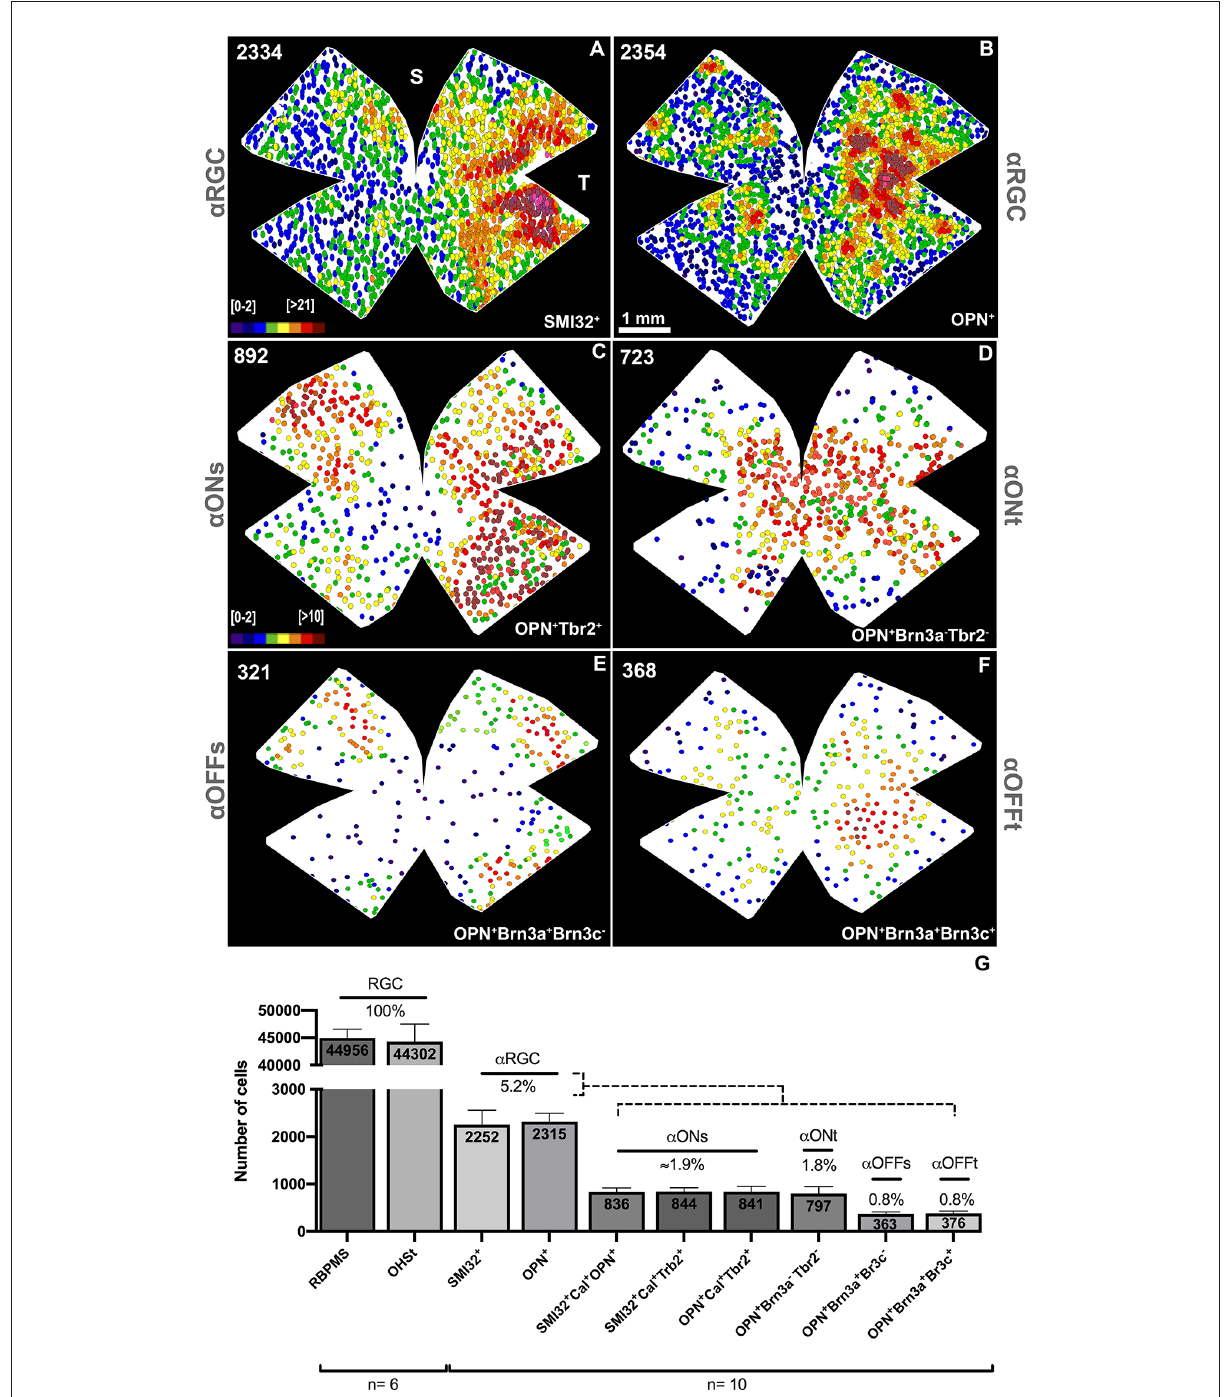
FIGURE4 Maps of the topographical distribution of α RGCs and its subtypes. Representative neighbor maps of the retinal distribution of the SMI32 + α RGCs (A) , OPN + α RGCs (B) and its subtypes ONs- α RGCs (C) , ONt- α RGCs (D) , and Off- α RGCs (E) . (F) Histogram showing the proportion of α RGC subtypes that constitute the total population of α RGC. (G) Bar histogram showing the mean of total RGCs retrogradely traced with OHSt from the opticnerveorimmunodetectedwithRBPMs; α RGCsimmunodetectedagainstSMI32orOPN;ONs- α RGCs(SMI32 + Cal + OPN + ,SMI32 + Cal + Tbr2 + , and OPN + Cal + Tbr2 + ); ONt- α RGCs (OPN + Brn3a − Tbr2 − ); OFFs- α RGCs (OPN + Brn3a + Brn3c − ) and OFFt- α RGCs (OPN + Brn3a + Brn3c + ). The percentages of each cell type are represented concerning the total number of RGCs retrogradely traced with OHSt. The color scale goes from 0 (purple) to 21 or more (red) (A,B) or 10 or more (red) (C–F) neighbors in a radius of 0.165 mm. The number in the superior left corner (A–F) reflects the total number of RGCs counted in that retina. S, Superior; T, Temporal. Scale bar: 100 µ